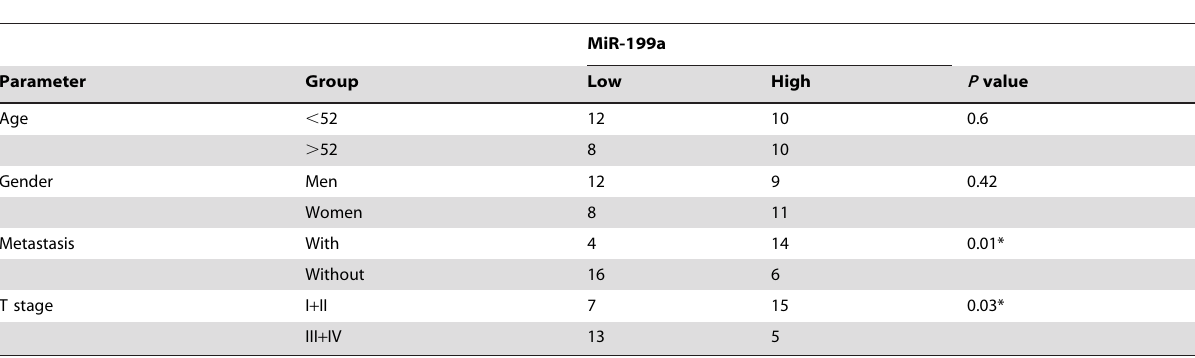
Table 3. MiR-199a expression is correlated with the clinical features of patients.